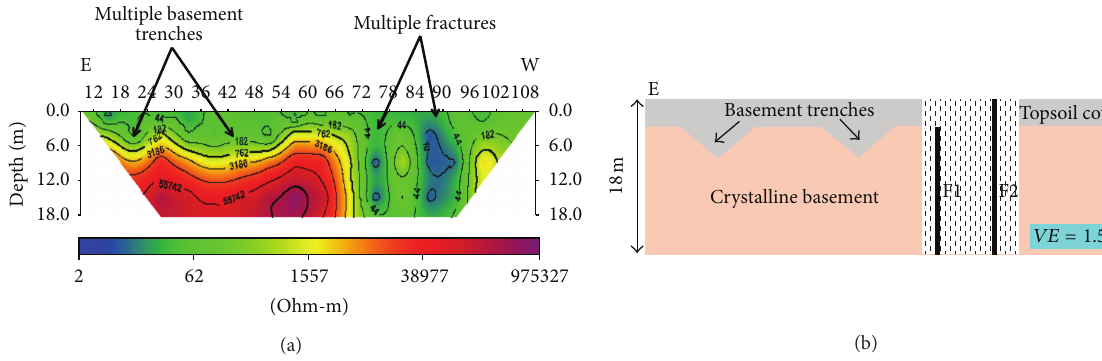
end of the profile and multiple depressions (trenches) within the adjacent high resistivity crystalline basement to the East. (a) Inverted 2D resistivity structure along TR2, (b) conceptual geologic cross-section along traverse 2. Deep seep of surface waters within the fractures leads to very low resistivity responses. Alternately, the entire grey shaded zone could represent a continuous zone where brecciation was heterogeneous. Above the multiple fractures a broad flood plain where the stream course is less entrenched has developed.